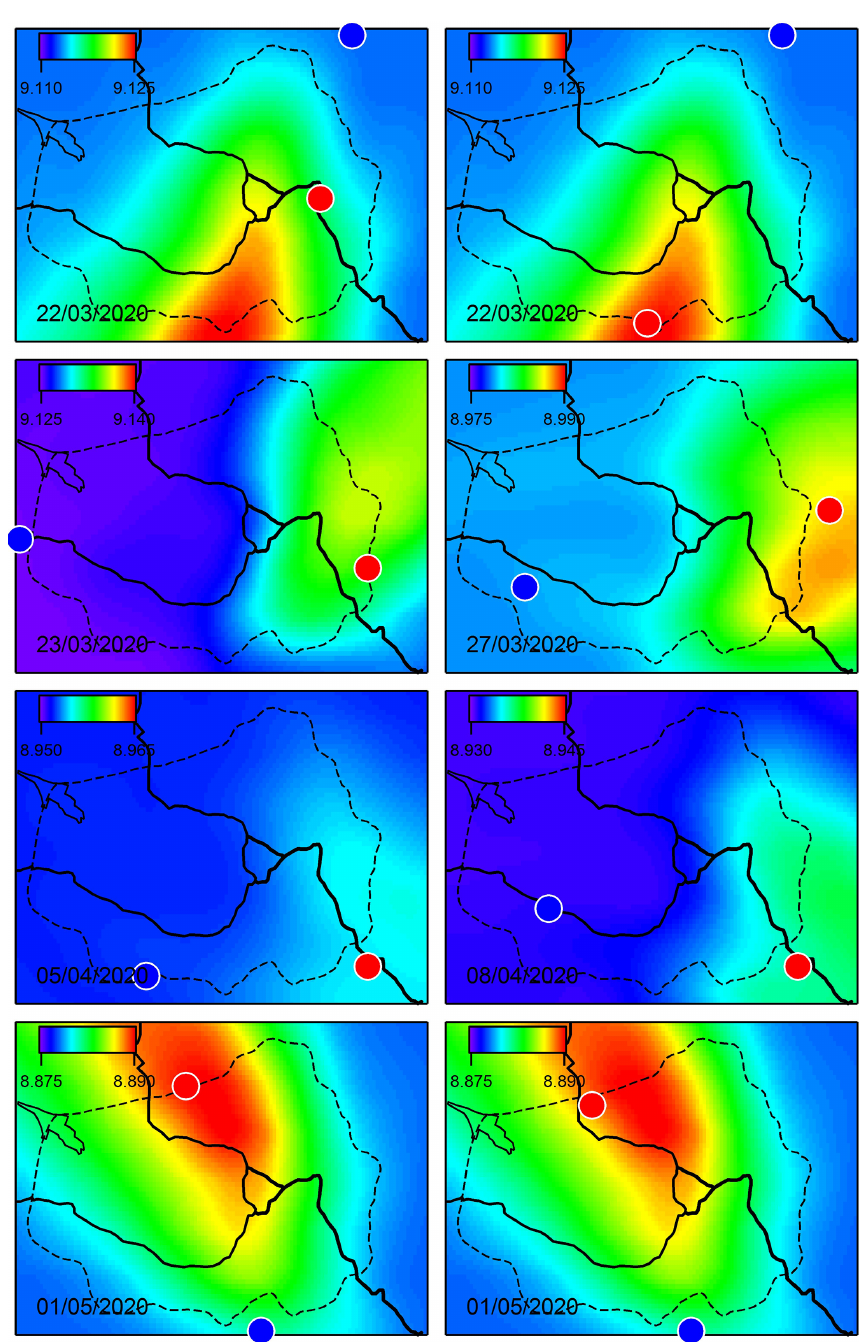
Figure A2. Urban pollution CO 2 plume over St Petersburg calculated with HYSPLIT model for the days of field campaign in 2020 (10:00UTC). The colour bar units for TC CO are 10 21 cm − 2 . The blue and red circles indicate the locations of upwind and downwind 2 FTS observations,